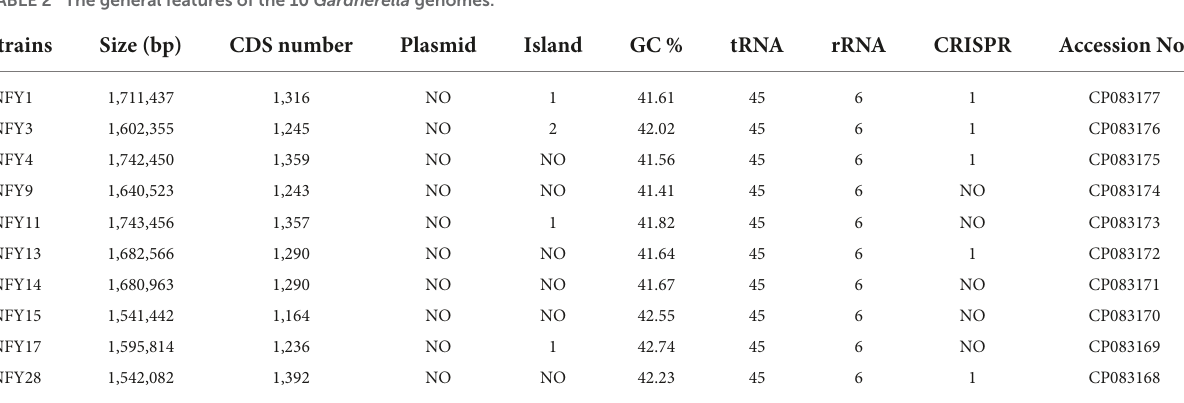
TABLE 2 The general features of the 10 Gardnerella